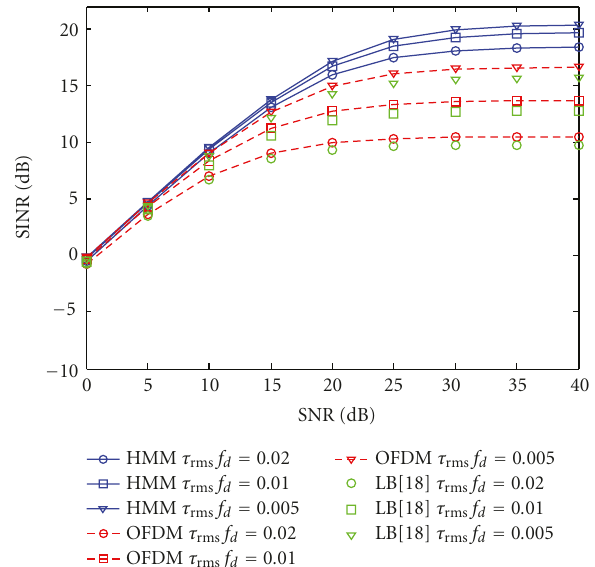
Figure 5: E ff ects of channel spread factor on SINR for hexagonal multicarrier